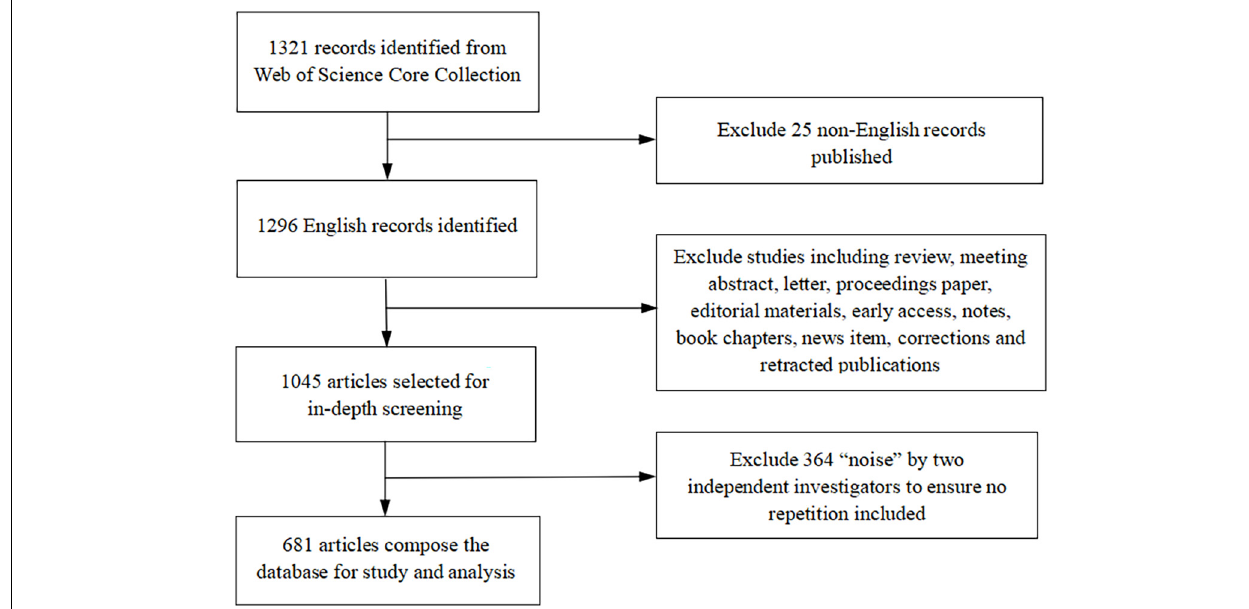
FIGURE 1 | The flowchart of methodology.